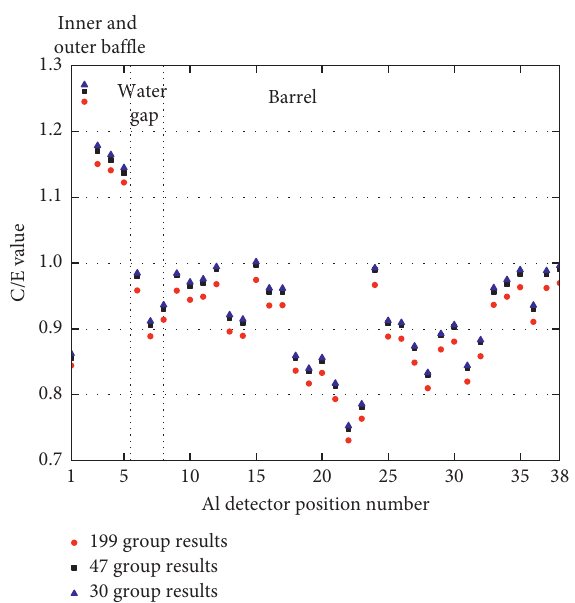
Figure 10: Comparison of group structure of the 27 Al(n, α ) 24 Na